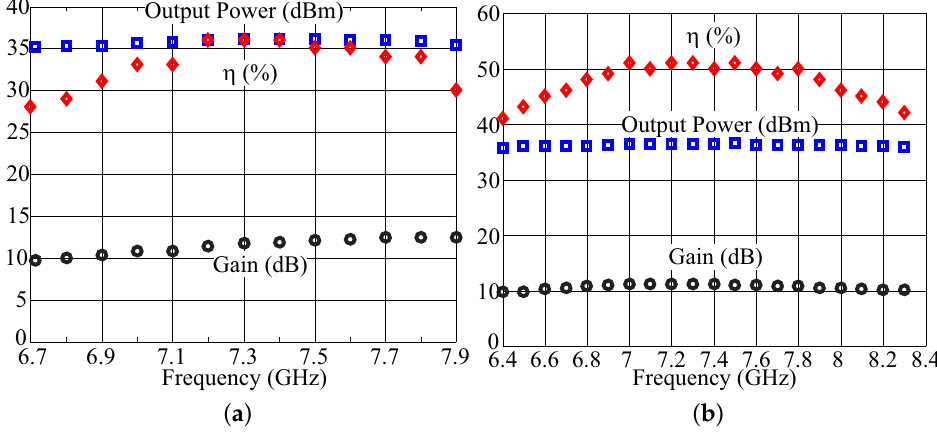
Figure 7. CW power performance vs. frequency for the Tuned Load ( a ), and Harmonic Tuned ( b ) PAs. Drain bias voltage is 30 V for both PAs. Drain bias current is 60 and 30 mA, respectively.